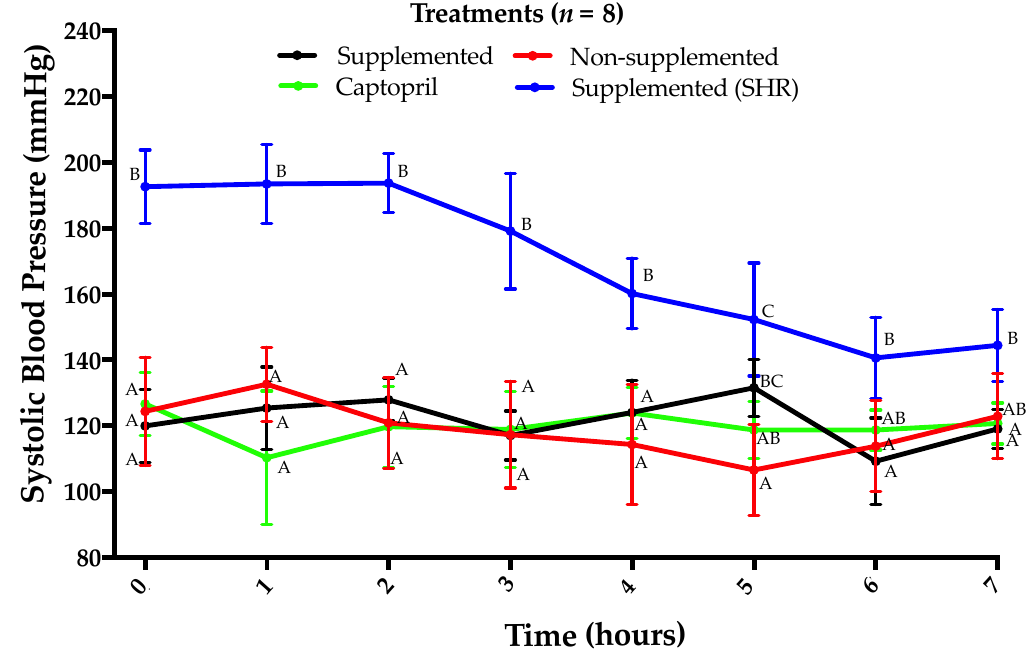
Figure 2. Evaluation of SBP in normotensive WKY and SHR. WKY ( n = 24) were randomly allocated into three groups: supplemented (amaranth hydrolysate, 1.2 g / kg body weight), captopril (25 mg / kg body weight), and non-supplemented (water only; 1.5 mL). An additional group of supplemented SHR ( n = 8) was evaluated (1.2 g / kg body weight). Di ff erent letters (A, B, or C) indicate significant di ff erences among groups at the same week. The data were analyzed by analysis of variance and Tukey’s test. The results are shown as means with standard